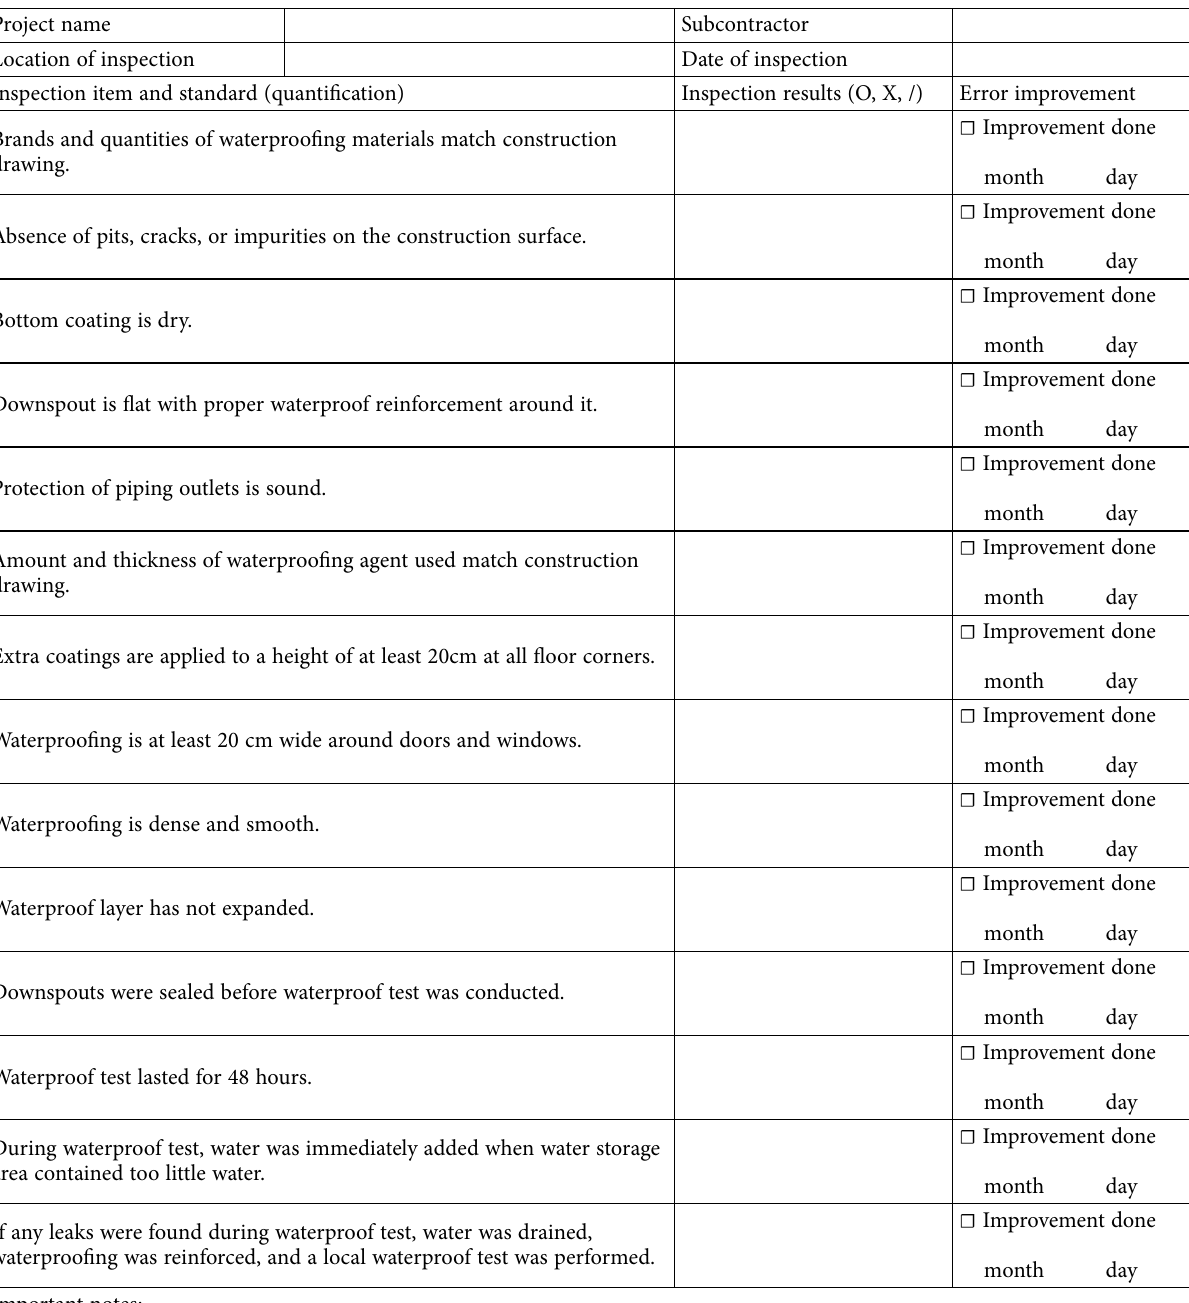
Figure 11. Prototype of designed checklist for private housing project quality